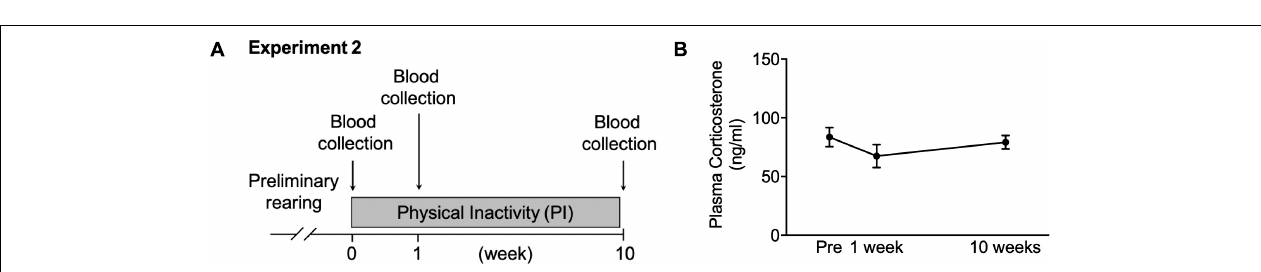
FIGURE 2 | Comparison of the physical activity amount in the standard and PI cages. (A) Physical activity amount per hour during 1 day. (B) Physical activity amount during daytime (left), during nighttime (center), during 1 day (right). All data are presented as the mean ± SEM (Cont cage, n = 7; PI cage, n = 6). Data were analyzed using two-way ANOVA with Bonferroni’s post-hoc test (A) , and unpaired t -test analyzed data (B) . * p < 0.05, *** p < 0.001 in comparison with the Cont mice.